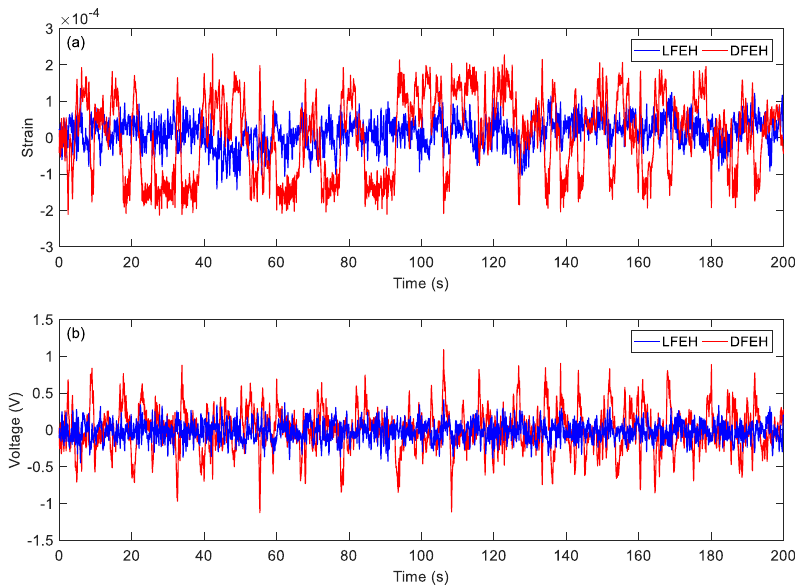
Figure 13. ( a ) Time histories of strain response, ( b ) time histories of voltage response ( v = 4.0 m/s). As the wind speed increases to v = 4.0 m/s, the jumping happens mostly between the static and the neutral equilibrium positions; since it happens densely, the output voltage increases accordingly.